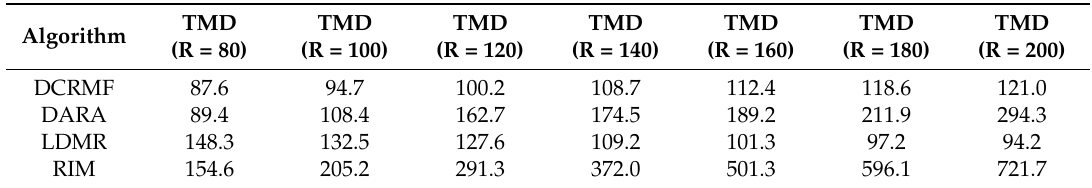
saves more movement overhead.